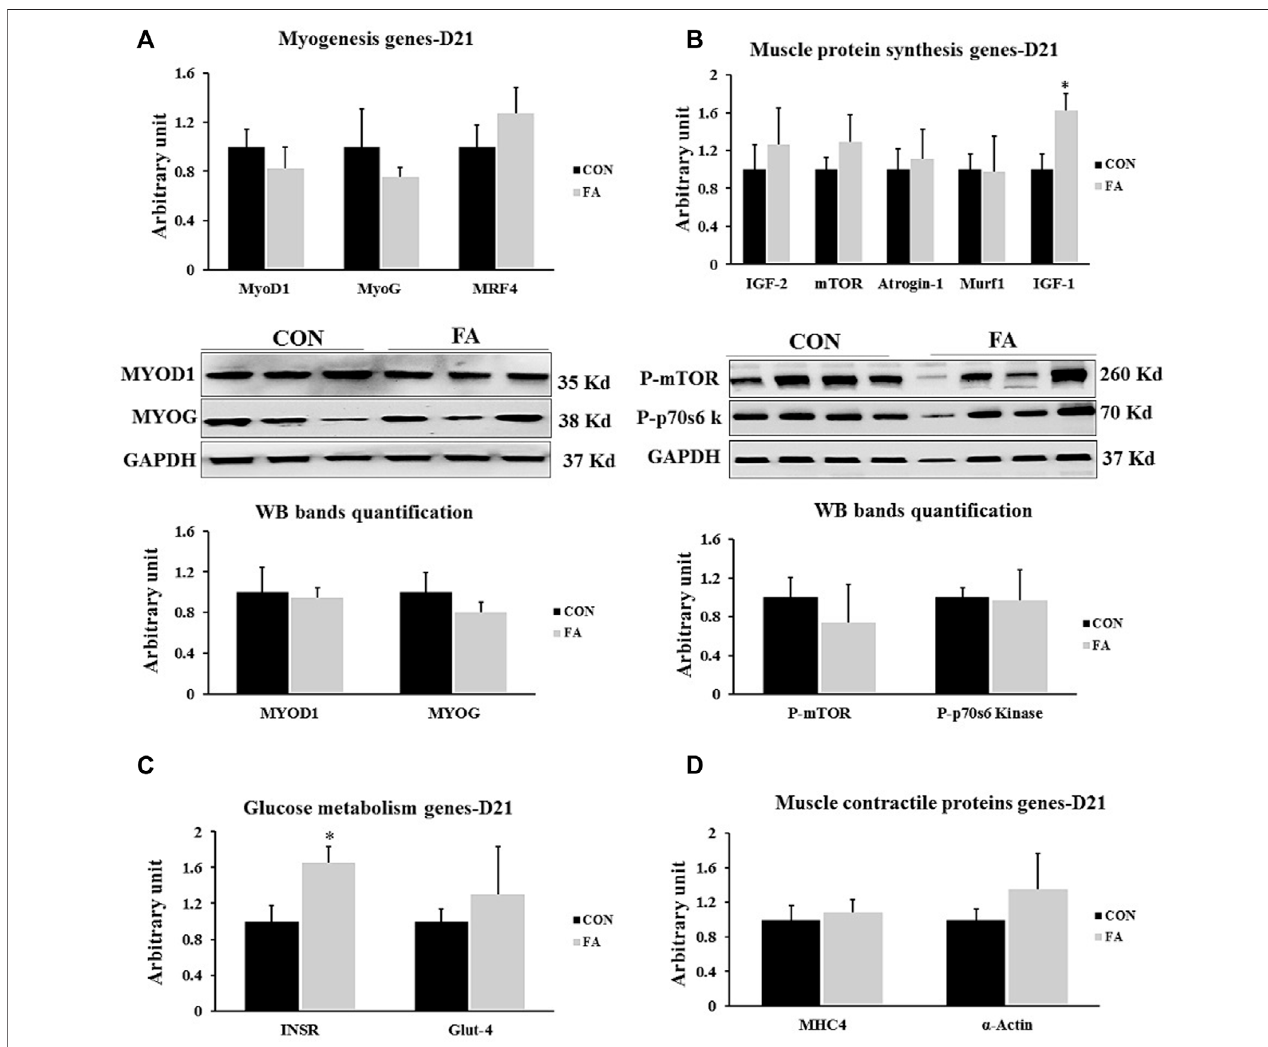
FIGURE7| EffectofmaternalintakeofEPA/DHAongenesregulatingmyogenesis,muscleproteinsynthesis,glucosemetabolism,andmusclecontractileproteins inweanedmice(21 dayspost-parturition).Themotherswereassignedtotwogroups,onereceivedcontroldiet(CON)andtheotherwasfedEPA/DHAenricheddiet(FA) (A) Quantitative RT-qPCR and representative image and densitometric analysis of western blot of genes regulating myogenesis (B) Quantitative RT-qPCR ( n = 8) and representative image and densitometric analysis of western blot ( n = 4) of genes encoding muscle protein synthesis (C) The relative expression of muscle glucose metabolism regulating genes. (D) qPCR analysis of genes regulating muscle contractile proteins. The raw Ct was normalized to the value of 18 s. All data represent as mean ± SEM. p < 0.05 by Student ’ s t-test.